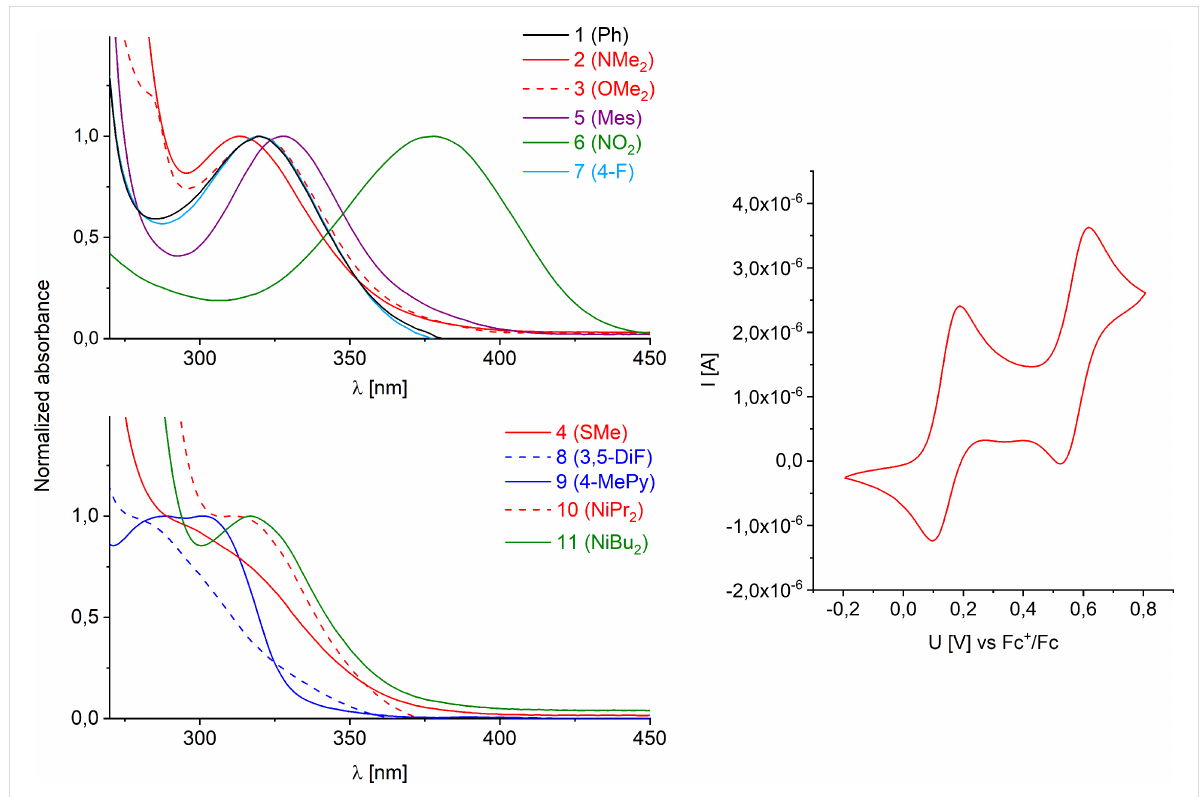
Figure 3: Normalized UV–vis absorption spectra above 290 nm of N -phenylphenothiazines 1 – 11 (left) and representative cyclic voltammogram of 2 (right).